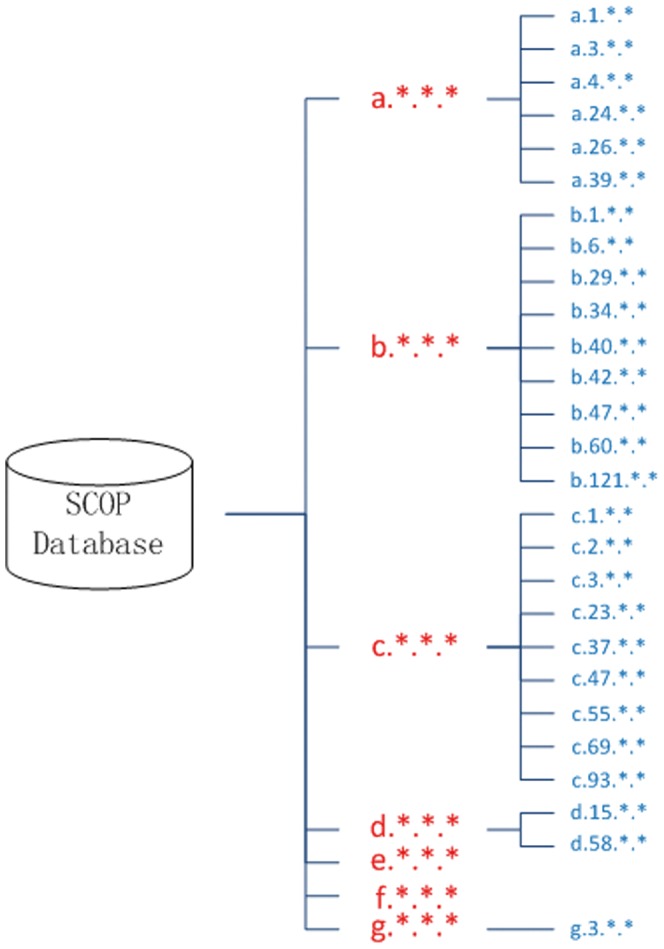
Comparison of the two datasets.In each query description, the first letter represents the class name and the second digit represents the fold number. The SCOP dataset that was used in this paper is shown in red. Seven classes containing 1195 folds (which are omitted in the figure) from SCOP dataset are explained as: (a) all-α proteins (284 folds), (b) all-β proteins (174 folds), (c) α/β proteins (147 folds), (d) α+β proteins (376 folds), (e) multi-domain proteins (66 folds), (f) membrane and cell surface proteins and peptides (58 folds), and (g) small proteins (90 folds). The benchmark dataset [3] proposed by Ding and Dubchak, composed of the 27 folds that were extracted from SCOP, is shown in blue.